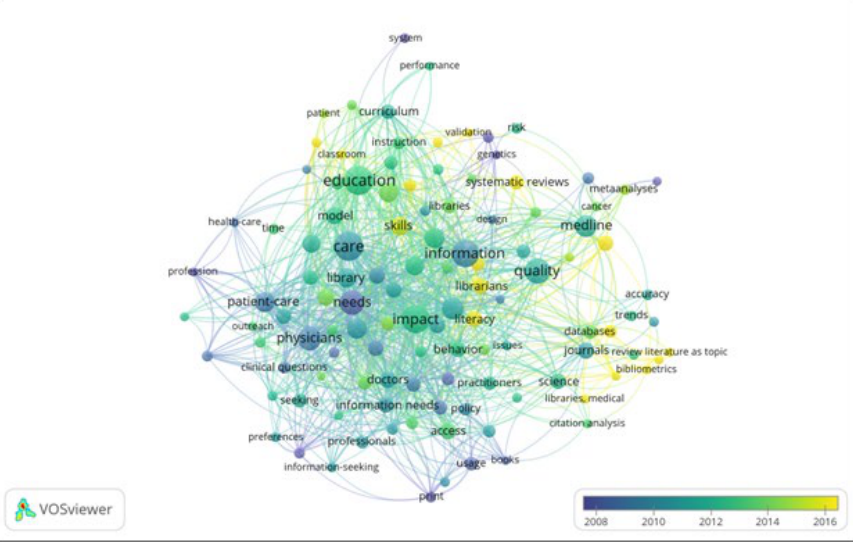
Figure 1 Overlay map of keyword co-occurrence over time for papers published at the Journal of the Medical Library Association